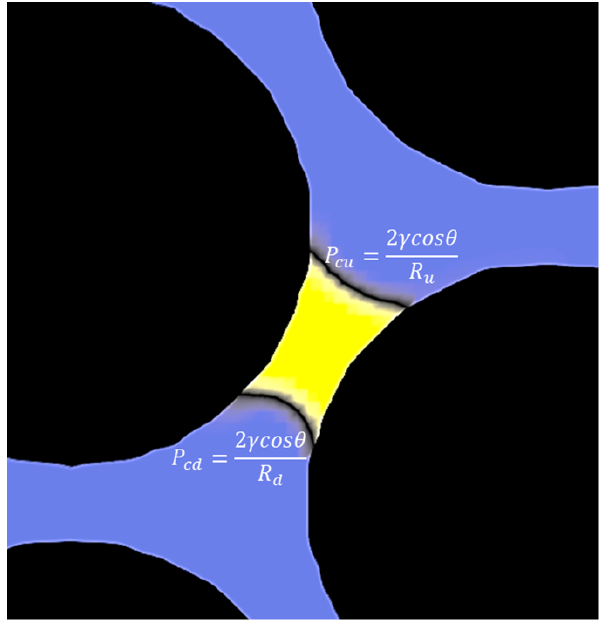
Figure 6. Schematic diagram of a single trapped oil droplet in the pore, where the yellow area represents trapped oil droplet, the blue area is water, and the black area is grain.